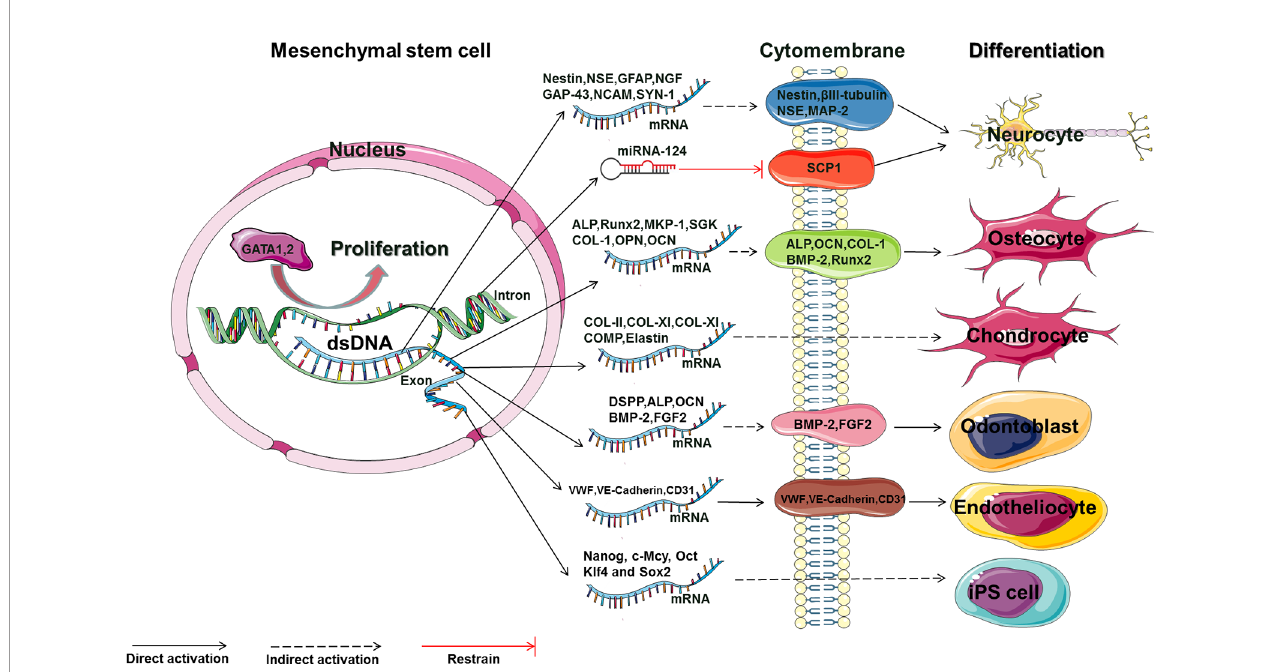
FIGURE 2 | The main molecular mechanism by which Rg1 affects the proliferation and differentiation of MSCs (GATA, GATA-binding factor; NSE, neuron-speci fi c enolase; GFAP, glial fi brillary acidic protein; NGF, nerve growth factor; GAP-43, growth-associated protein 43; NCAM, neural cell adhesion molecule; SYN, synaptophysin; MAP-2, microtubule-associated protein 2; SCP-1, small C-terminal domain phosphatase 1; ALP, alkaline phosphatase; OCN, osteocalcin; COL, collagen; BMP-2, bone morphogenetic protein 2; RUNX2, runt-related transcription factor 2; COMP, cartilage oligomeric matrix protein; DSPP, dentin sialophosphoprotein; BMP-2, bone morphogenetic protein 2; FGF2, fi broblast growth factor 2; vWF, von Willebrand factor; VE-cadherin, vascular endothelial cadherin; Nanog, c-Mcy, Oct, Klf4 and Sox2: embryonic stem cell-related transcription